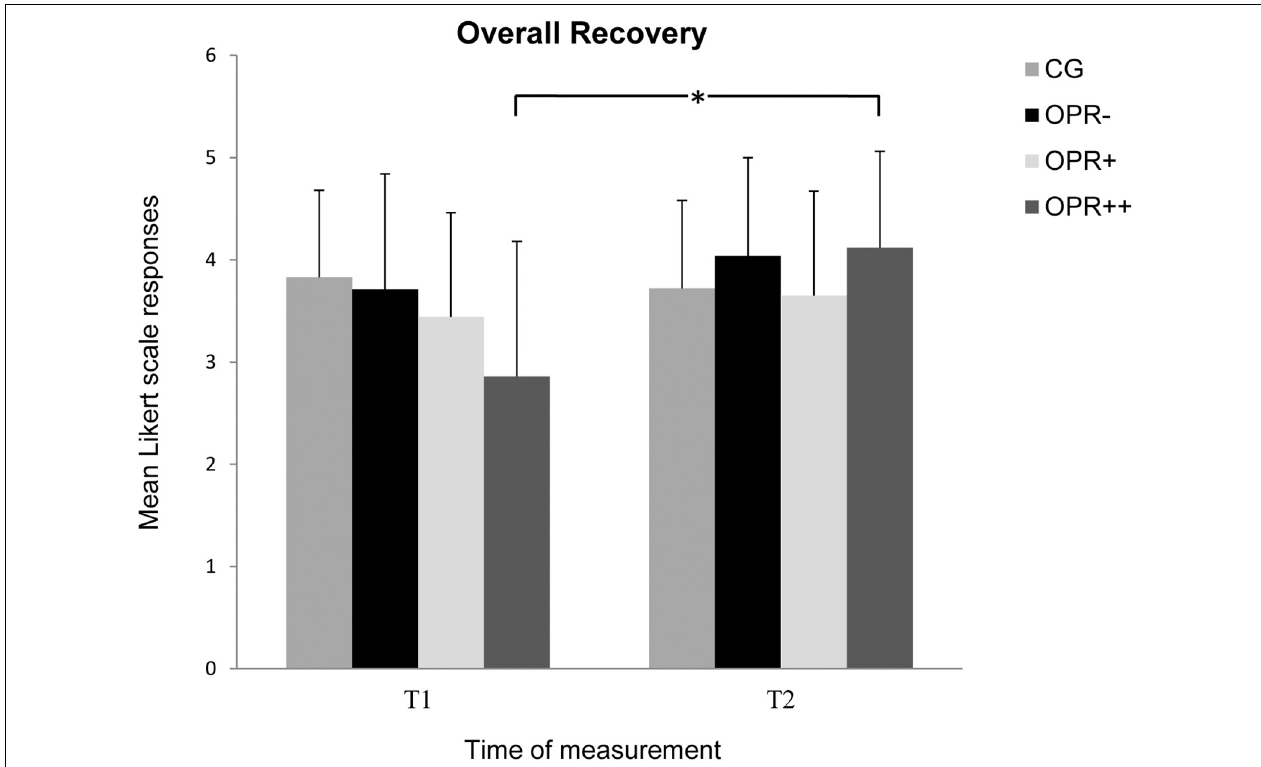
FIGURE 5 | The mean values of the Overall Recovery of the groups as a function of the time of measurement (T1, T2). The symbols represent across-participant means, and error bars show standard deviations. The 7-point Likert scale ranged from “does not apply at all” (0) to “fully applies” (6). (CG: control group without any intervention; OPR - group: got a filled bottle of water every day without any label on it; OPR + group: got a filled bottle of water every day with the label “Imagine I Am Health”; OPR ++ group: got a filled bottle of water every day with the label “Imagine I Am Health” and an audio file with a health mediation) (*p <